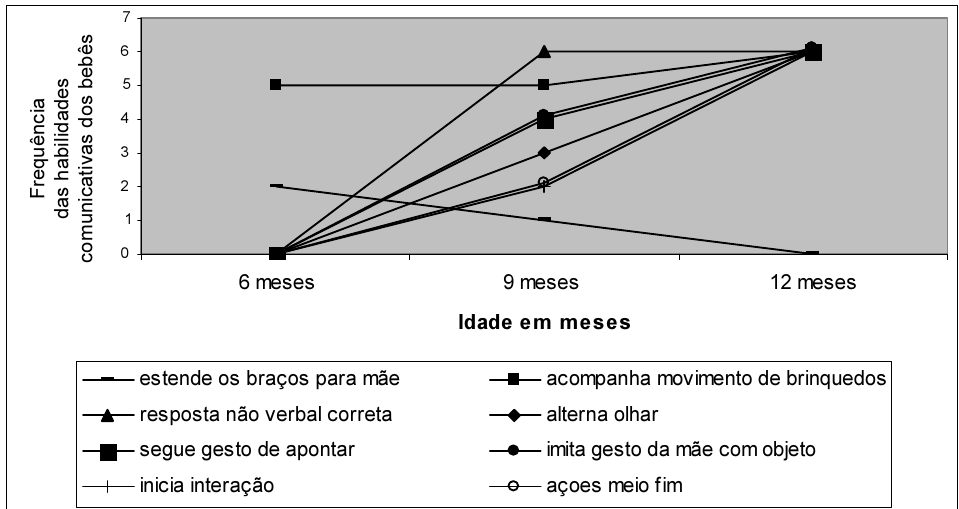
Figura 1 . Diagrama das configurações de atenção conjunta e habilidades comunicativas intencionais das díades mãe-bebê, nos três períodos evolutivos